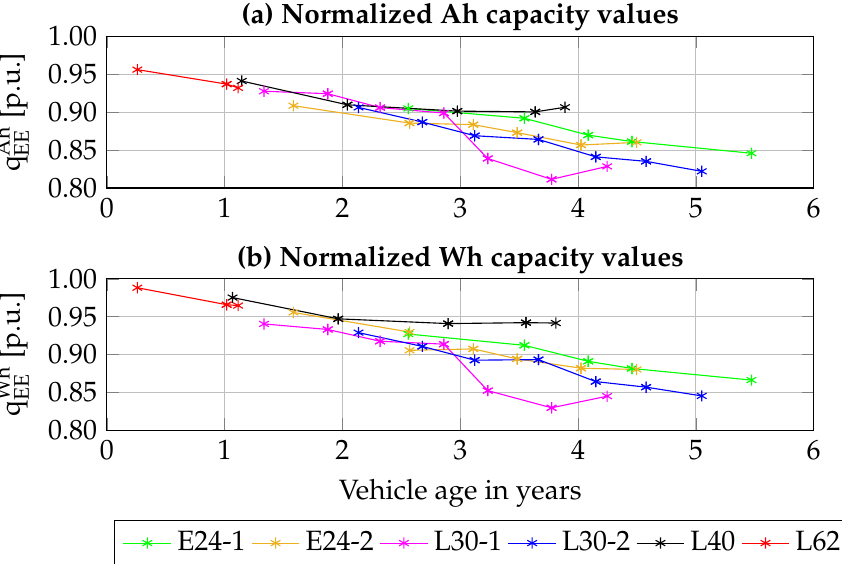
Figure 5. Normalized capacity measurements versus age of the vehicles in